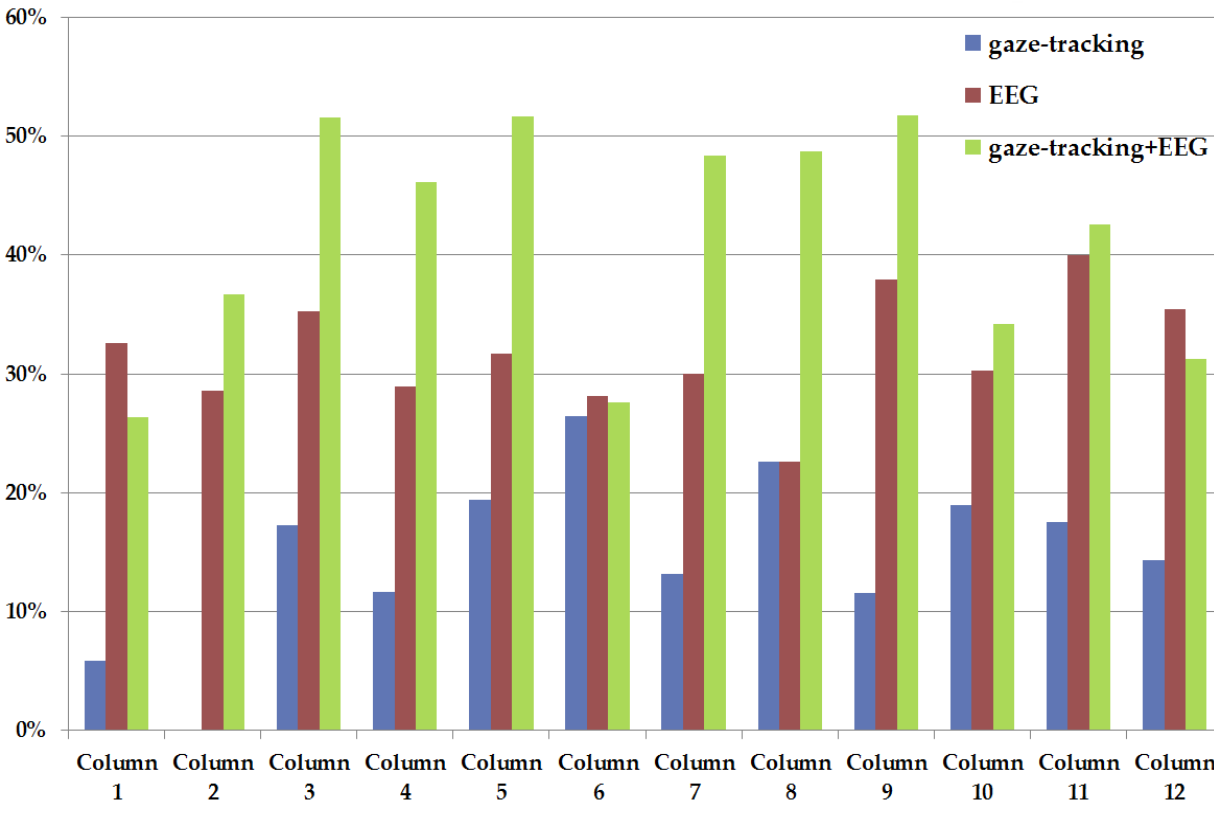
Figure 6. Comparisons of horizontal accuracies.